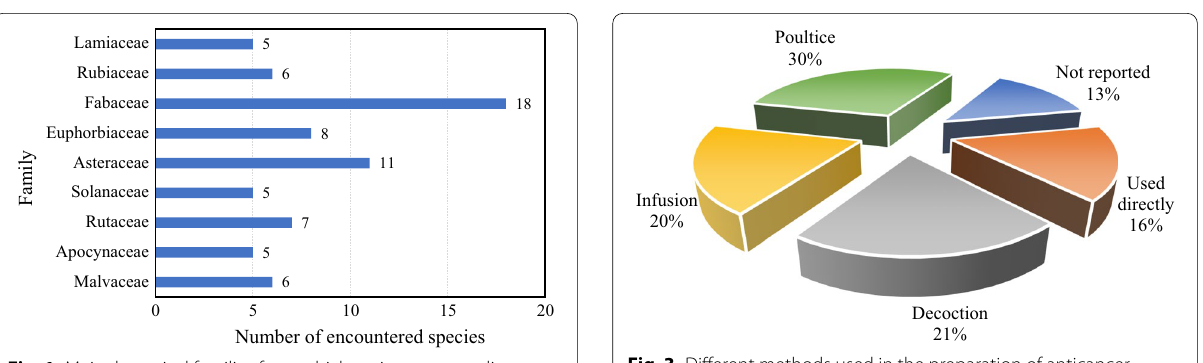
Fig. 1 Major botanical families from which antitumor remedies are obtained in Kenya